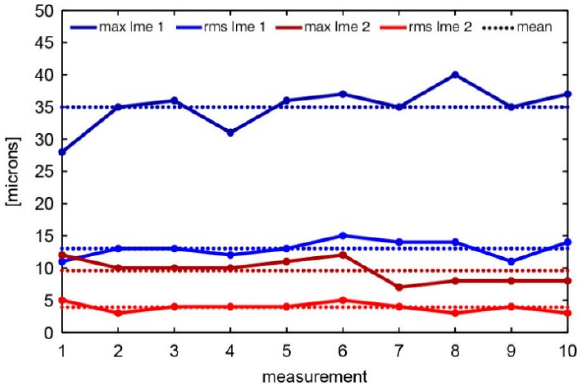
Figure 3. Quality characteristics (reference